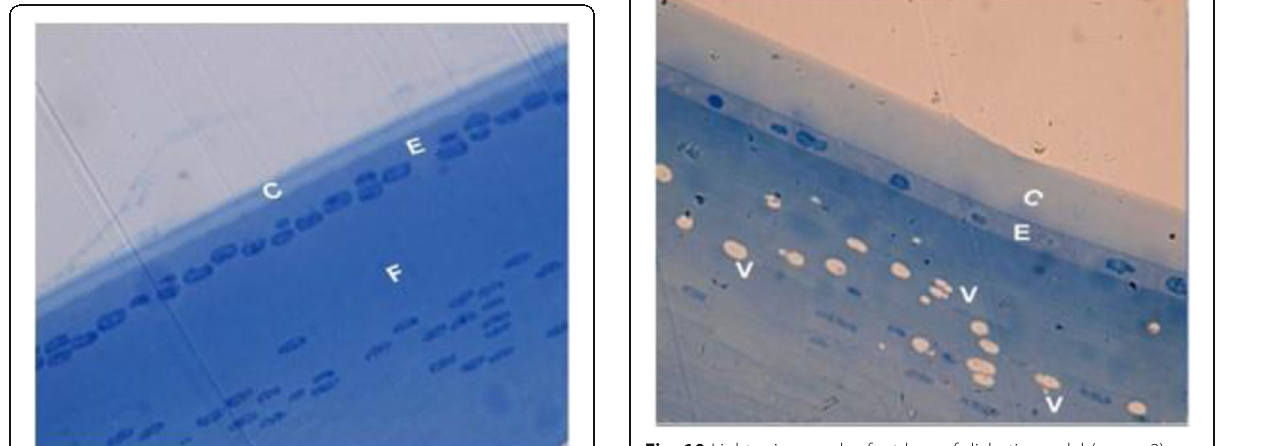
Fig. 10 Light micrograph of rat lens of diabetic model (group 2) showing thickened lens capsule (C), decreased mitotic figures of lens epithelium (E), and plenty of vacuoles (V) of lens fiber cells (Toluidine blue ×